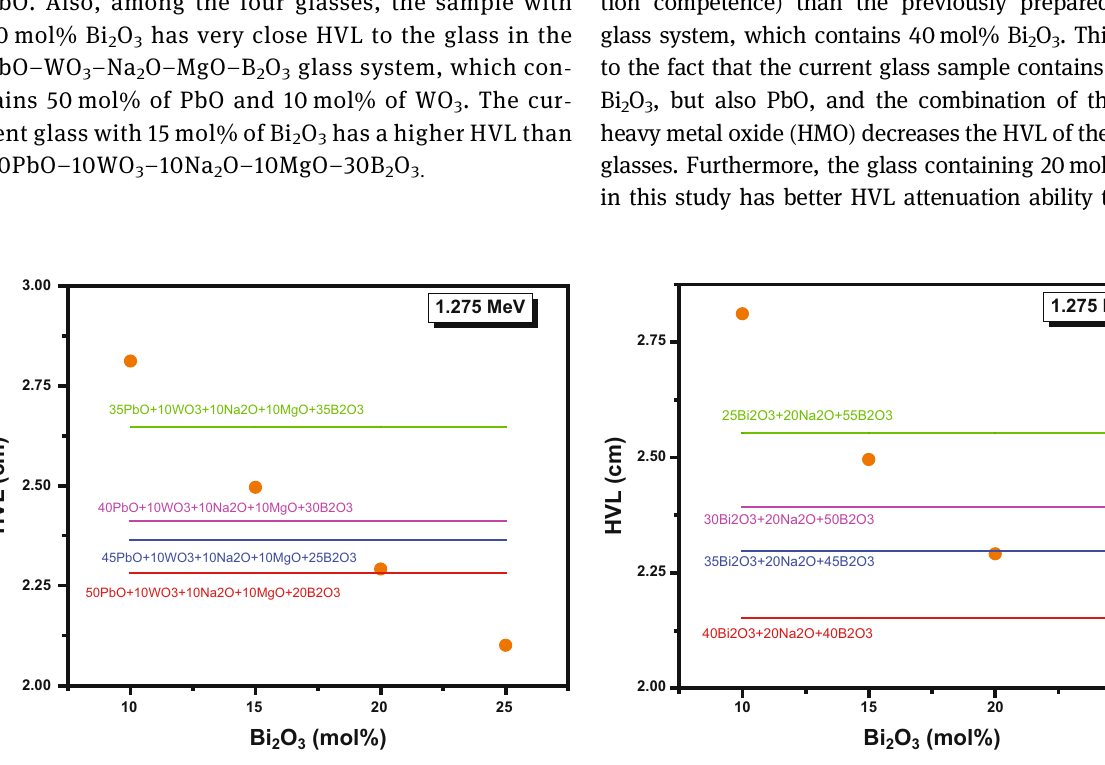
Figure 6: Comparison between the HVL for the prepared Bi 2 O 3 – PbO – CdO – B 2 O 3 glass system with the PbO – WO 3 – Na 2 O – MgO – B 2 O 3 glass system at 1.275 MeV.